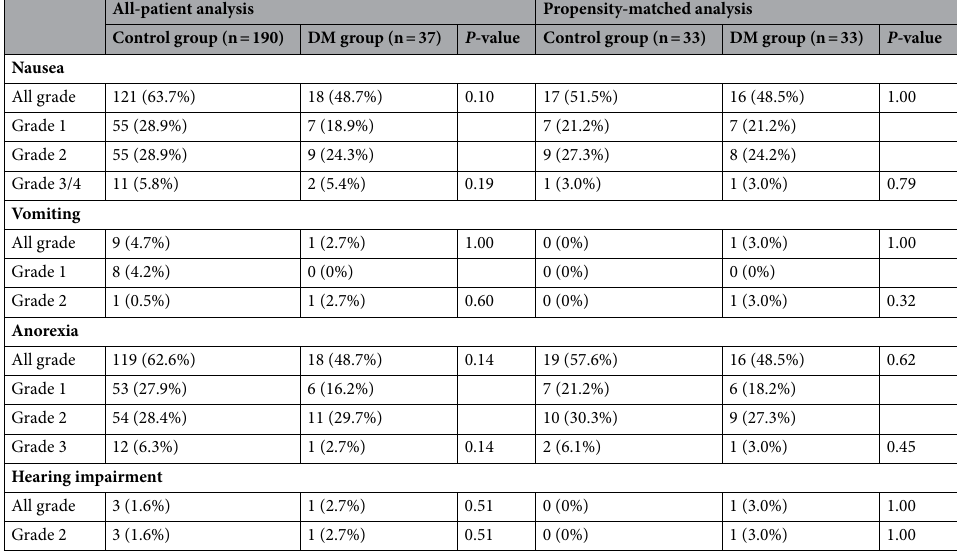
Table 2. Incidence and severity of nausea, vomiting, anorexia, and hearing impairment in all subsequent cycles. DM diabetes mellitus.